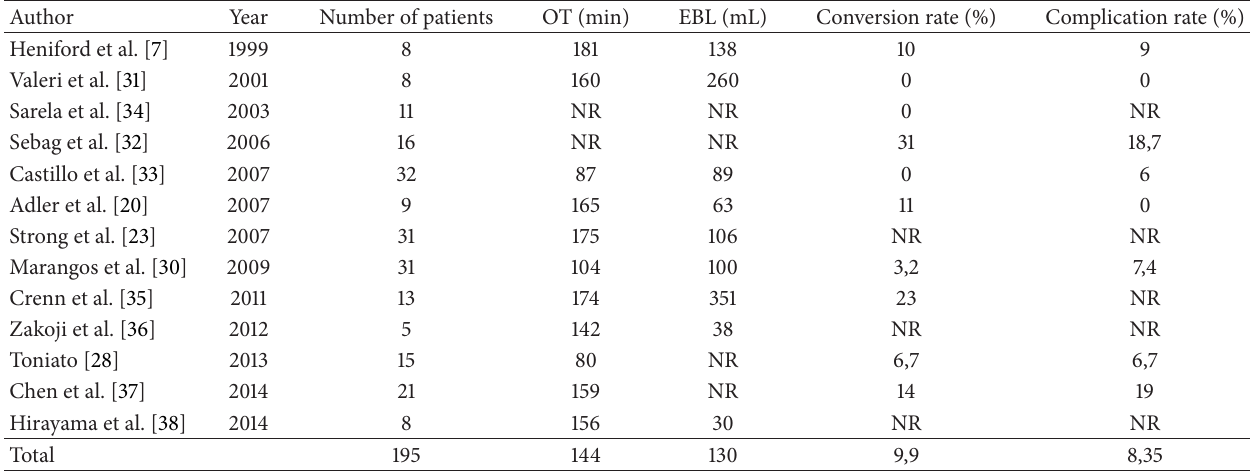
Table 3: Surgical results of LA for metastasis in previously published